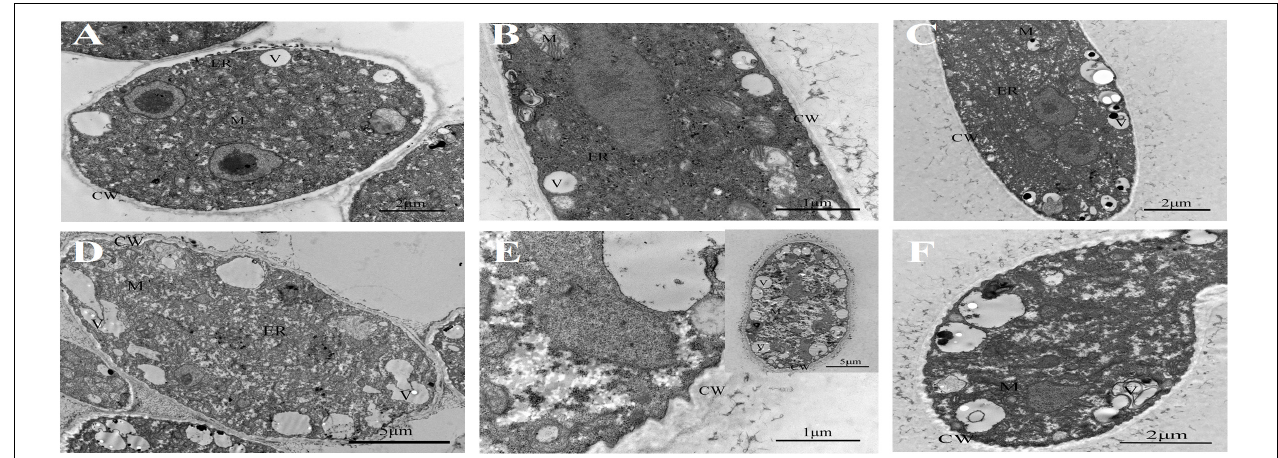
FIGURE 1 | Transmission electron micrographs of Botrytis cinerea with or without benzothiazole treatment. (A–C) Untreated B. cinerea at 12, 24, and 48 h. Many organelles were observed, including the cell wall (CW), vacuole (V), mitochondria (M) and endoplasmic reticulum (ER). (D–F) B. cinerea hyphae after fumigation with benzothiazole for 12, 24, and 48 h, showing many anomalous vacuoles, significant thickening of the cell wall, and indistinguishable organelles in the cytoplasm.